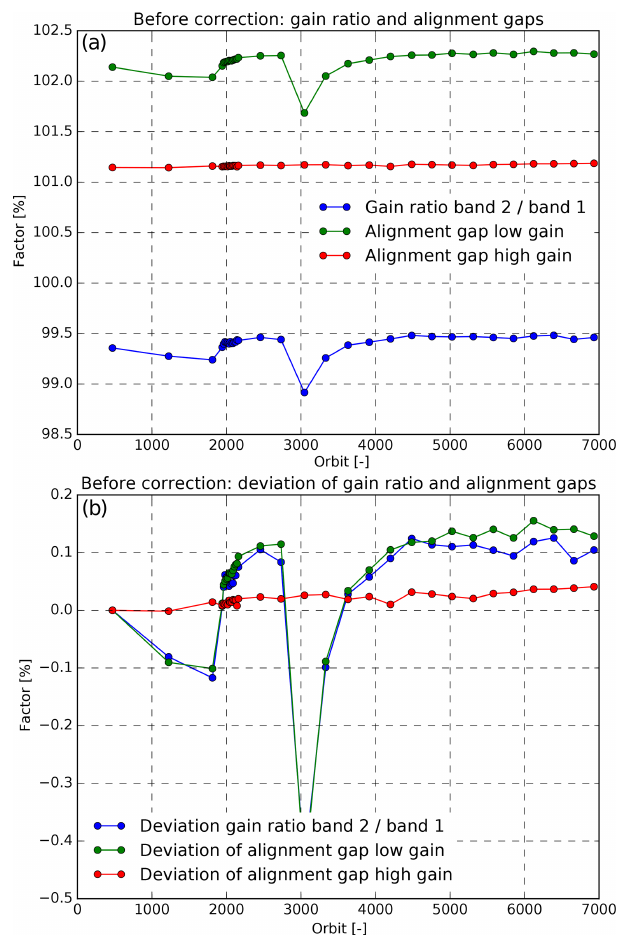
Figure 3. Without CCD gain drift correction, the alignment correc- tion factor ratio between bands 1 and 2 for low-CDD-gain (green) and high-CDD-gain (red) setting together with the relative drift of the computed gain ratios (blue). Panel (a) shows the absolute values, and panel (b) shows the values relative to the first available in-flight data. The alignment correction factor ratio for low gain follows the gain ratio drifts.